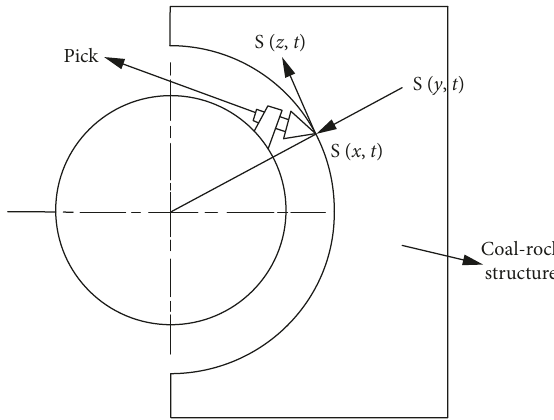
Figure 1: A schematic of interaction dynamic load between the pick and coal-rock